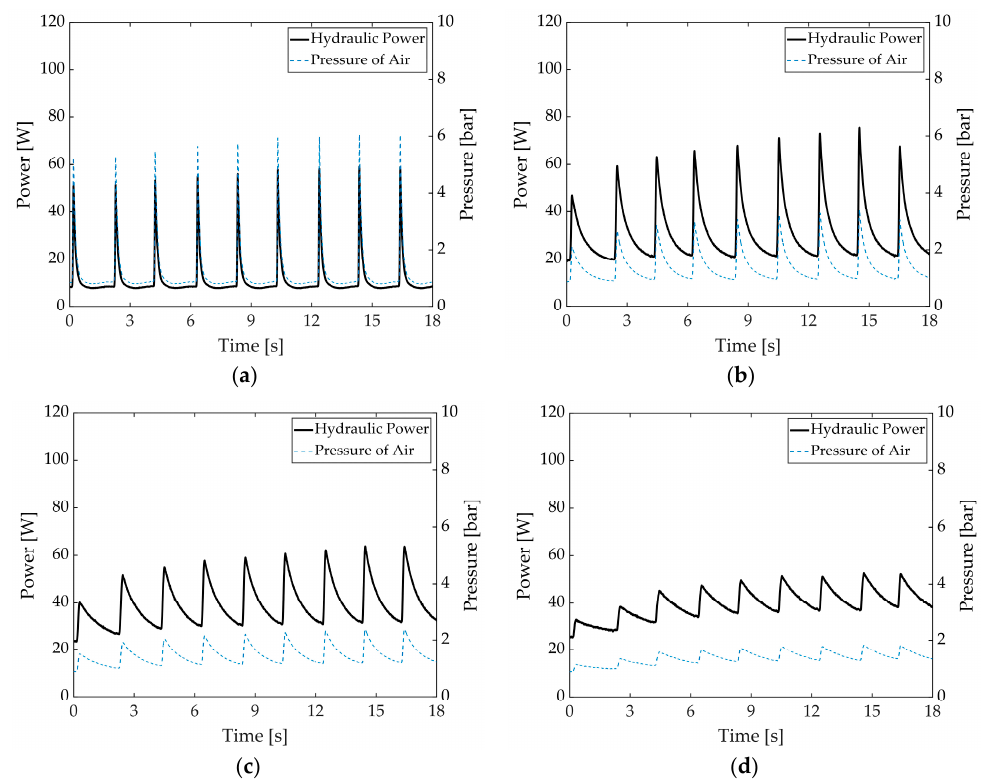
Figure 7. The hydraulic power and p air changing during transient for Re = 155,000 and: ( a ) VFR = 3.33%; ( b ) VFR = 16.67%; ( c ) VFR = 33.33%; ( d ) VFR = 66.67%.